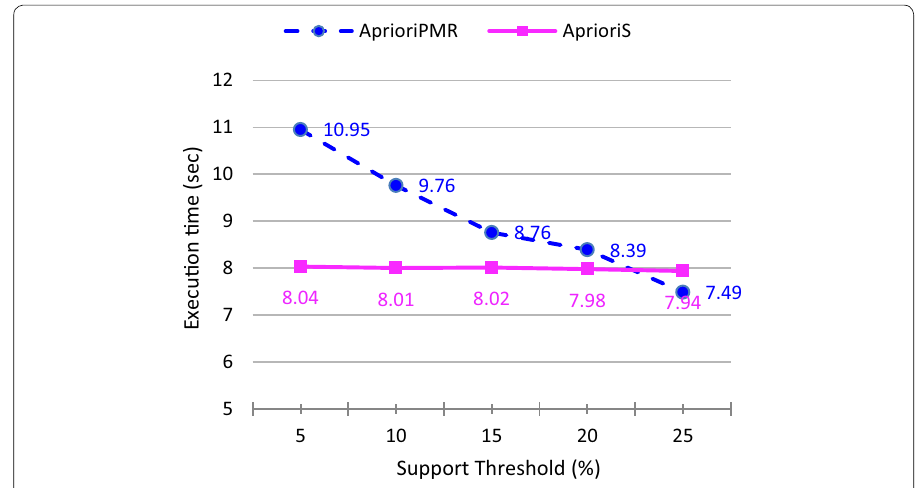
Fig. 8 Varying support thresholds. Result of execution time comparison between AprioriPMR and proposed AprioriS when vary support thresholds from 5 to